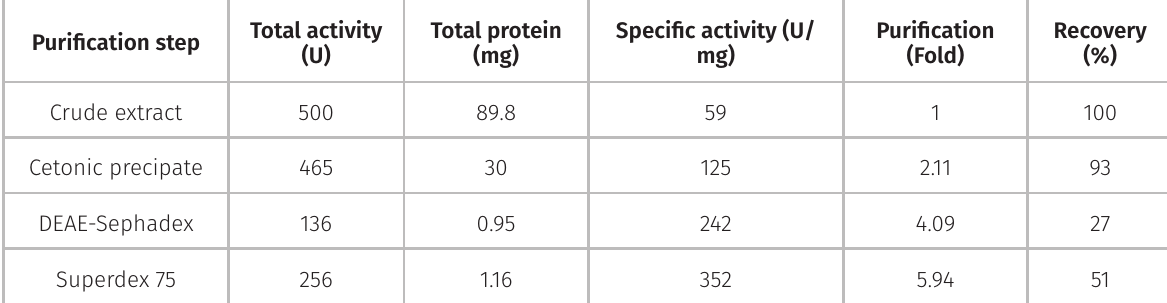
Table I. Purification steps of protease from Aspergillus sydowii. Purification